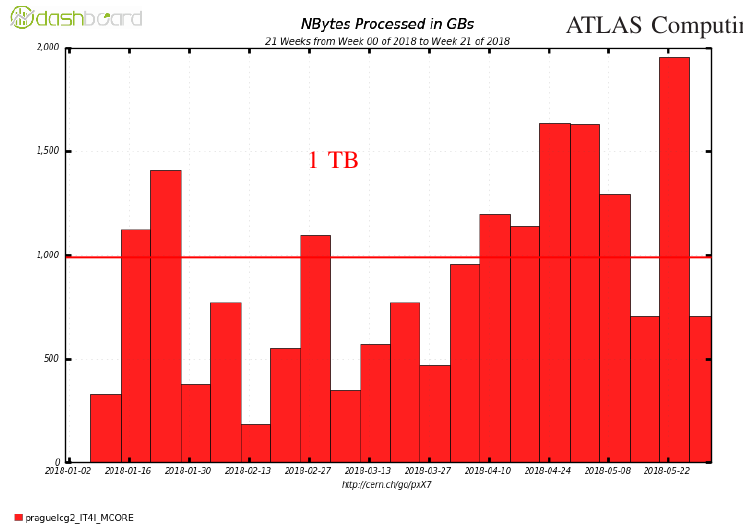
Figure 1. Cache reuse factor. Each bin represents number of files which were used N times where N is the number on the x axis. Figure 3. Amount of data processed every